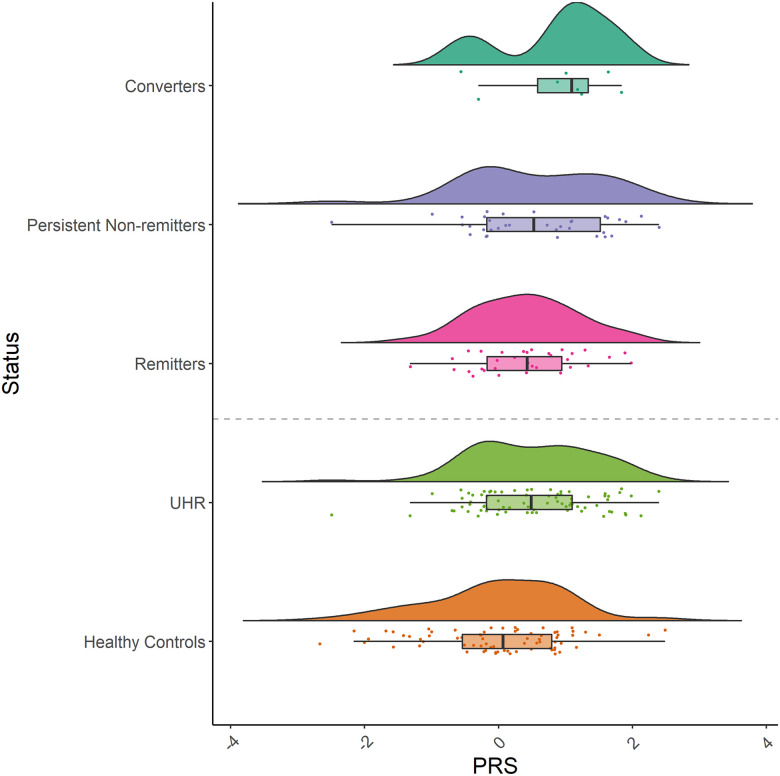
Raincloud plot of PGC SCZ-EAS standardized polygenic risk scores (PRS) in the Han Chinese group.Raincloud plots are presented for healthy controls, UHR, remission and conversion status. The raincloud plot aids data visualisation by combining a split-half violin plot, raw jittered data points, and central tendency of median through a boxplot.